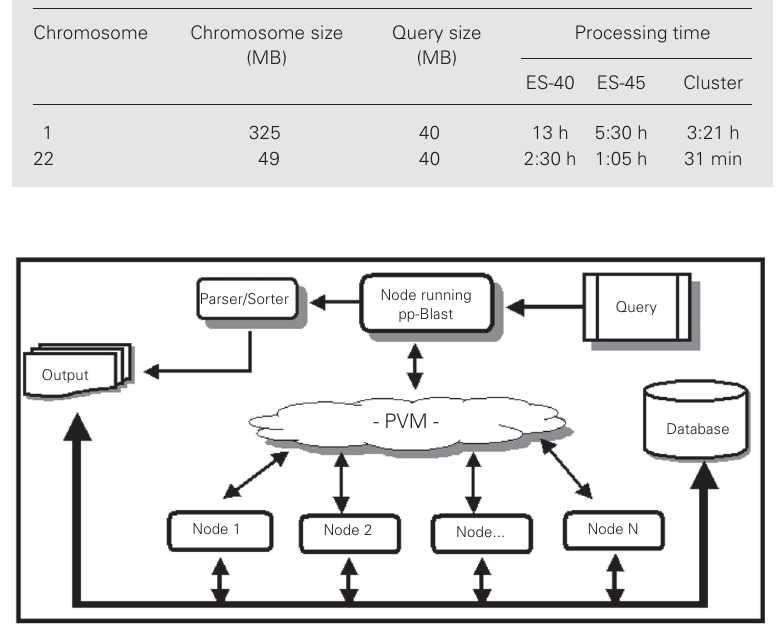
Table 2. Comparative performance of pp-Blast and regular Blast both running Blastn. pp-Blast was used in the context of a PC cluster (described in Table 1) while regular Blast was used with ES-40 and ES-45